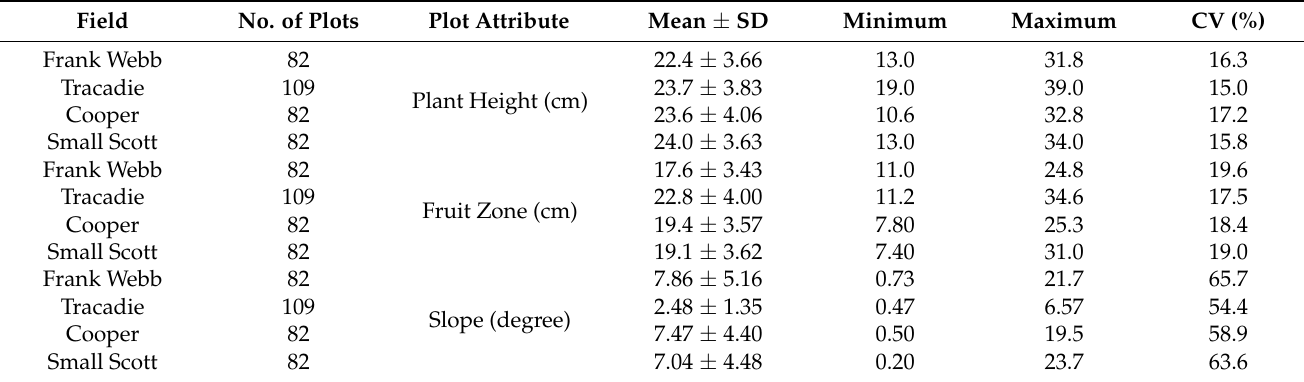
Table 1. Descriptive statistics of harvesting plot